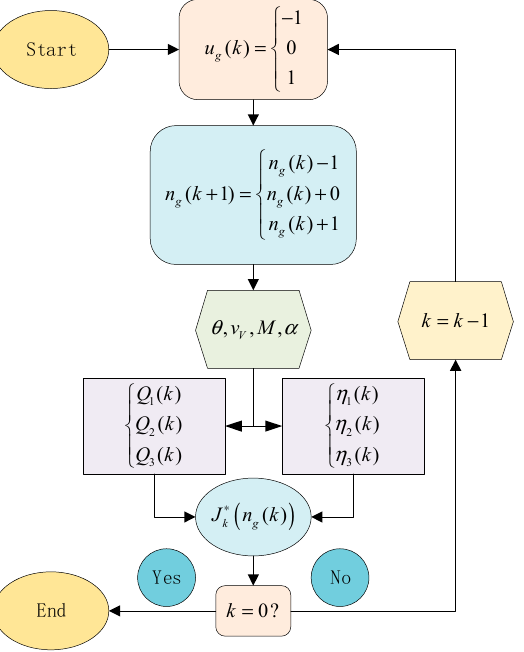
Figure 7. The flow chart of optimizing AT shift strategy based on DP algorithm.